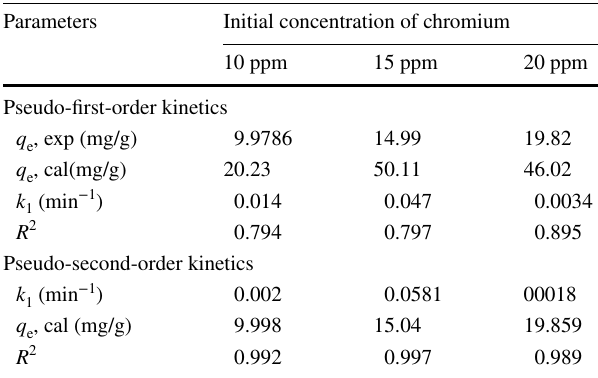
Fig. 12 Pseudo-second-order kinetic curve of Cr(VI) adsorption onto CTAB–kaolin Table 2 Pseudo-first- and second-order kinetic